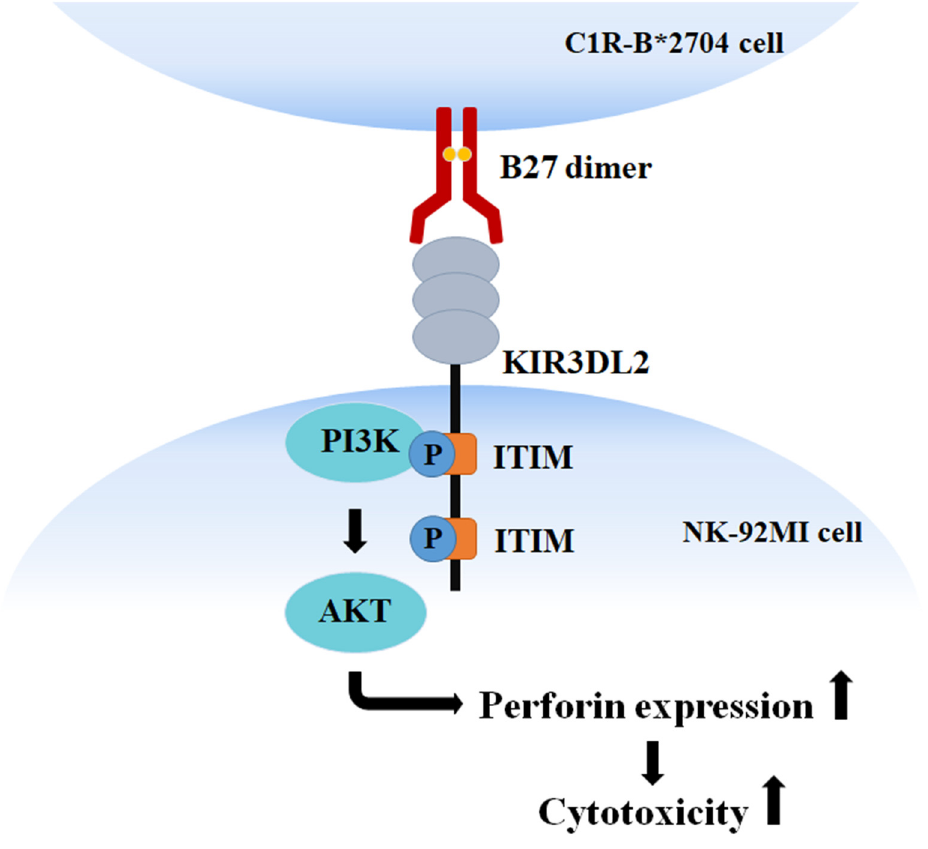
Figure 5. Schematic diagram illustrates the mechanism of the homo-oligomeric B*27-HC molecule to up-regulate the NK-92MI-mediated cytotoxicity.